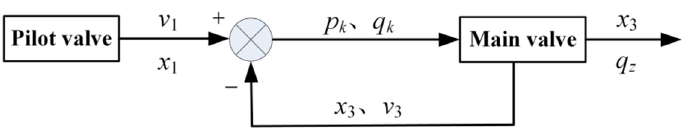
Figure 3. Block diagram of the proportional valve.